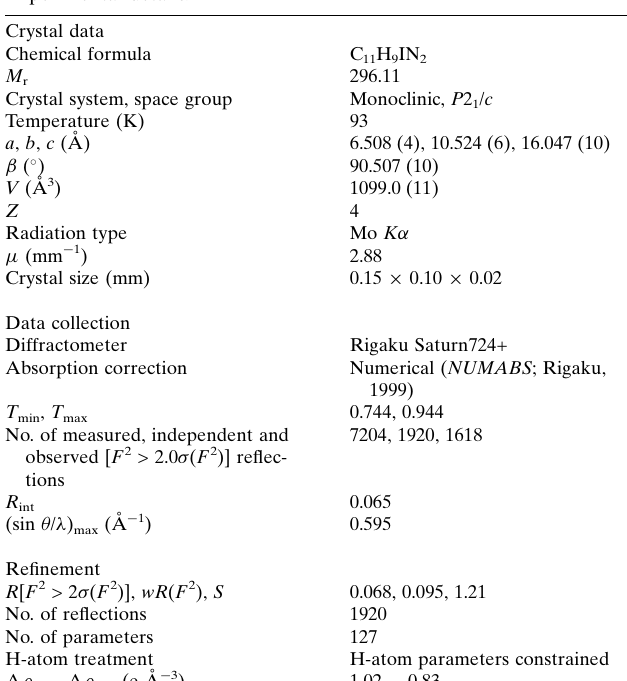
Table 2 Experimental details.